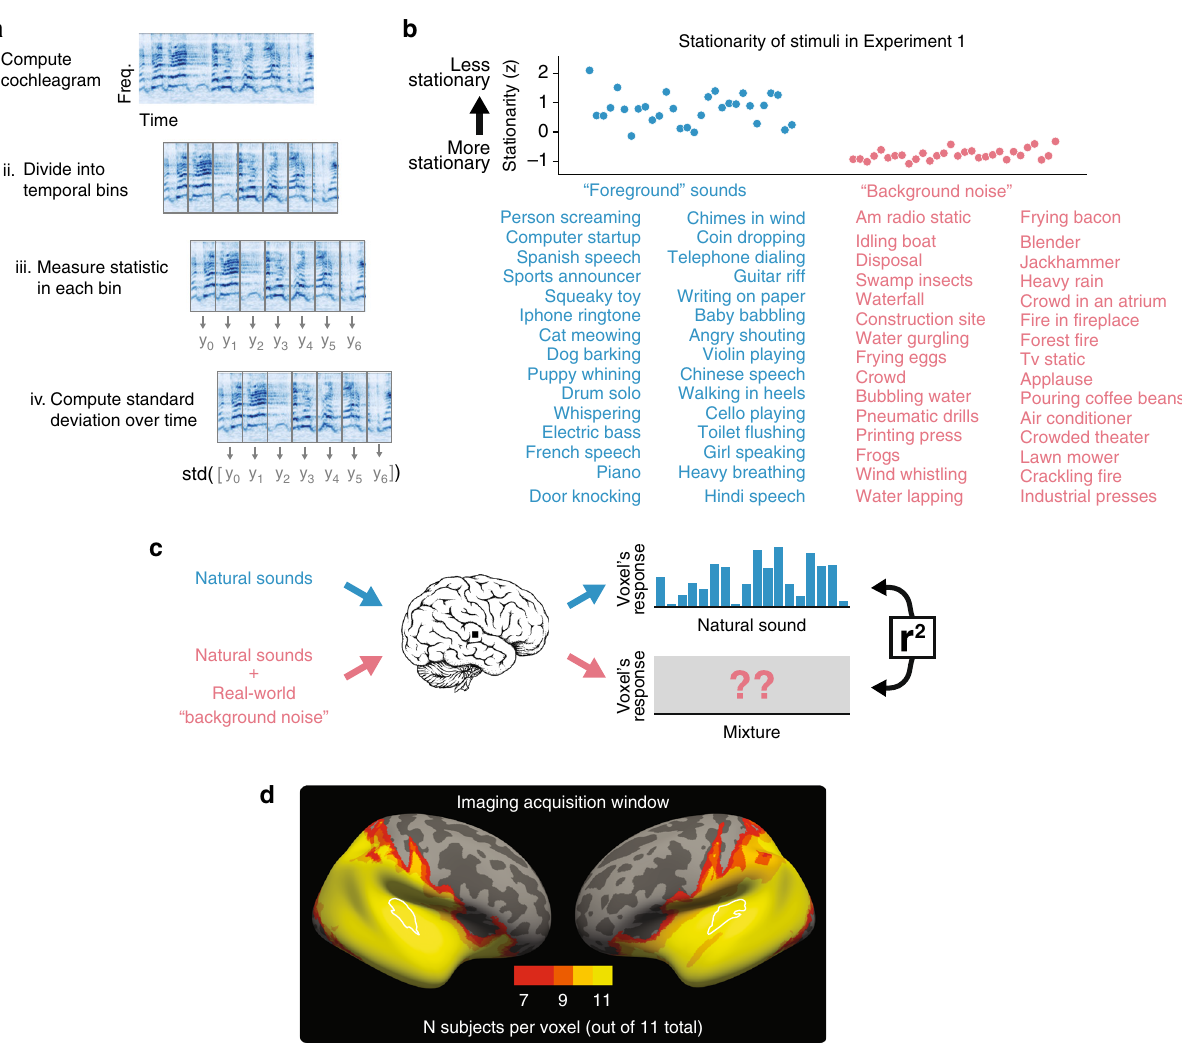
Fig. 1 Experimental design. a Schematic of stationarity score used to select real-world “ background noise. ” b Sounds selected by stationarity. Top: stationarity score for each sound in Experiment 1. Tick marks indicate z-score units. Bottom: list of all 30 natural sounds, and all 30 real-world background noises used in Experiment 1. c Schematic of stimulus logic and analysis. d Heatmap of fi eld of view in Experiment